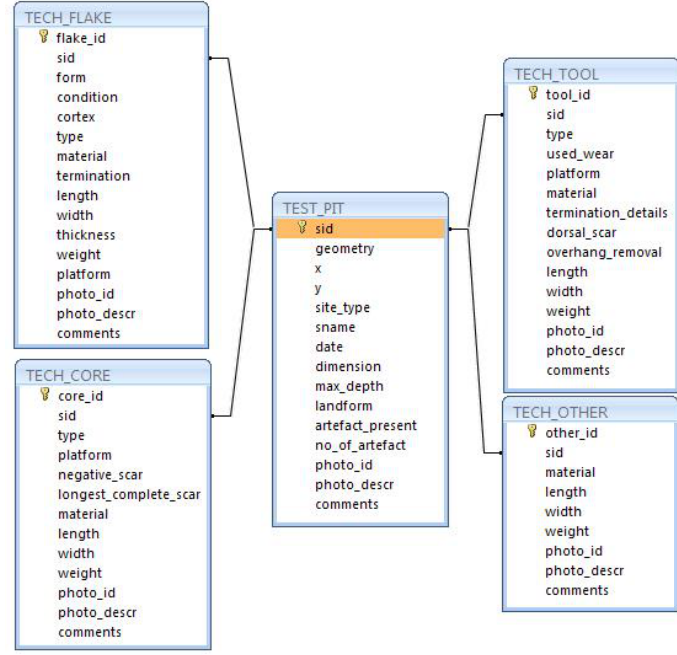
Figure 2. Relationship diagram of